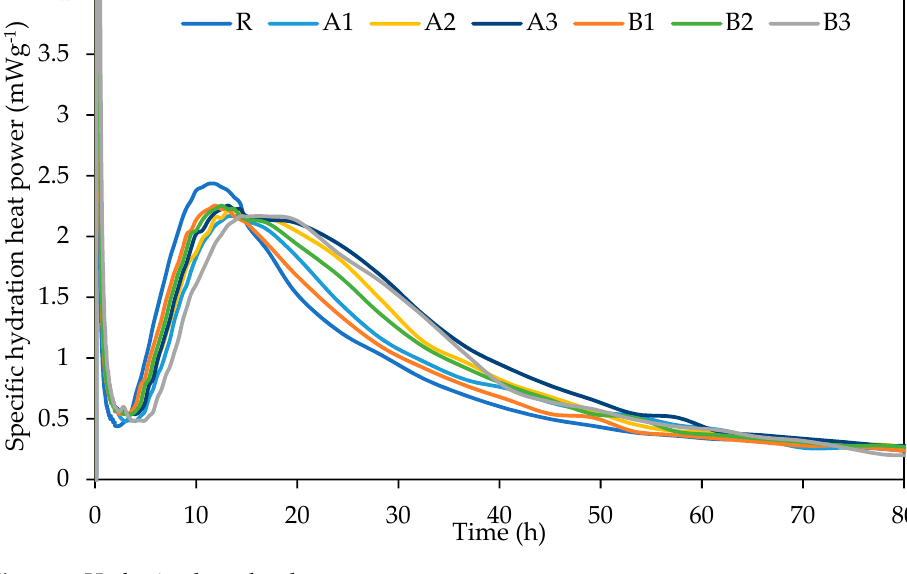
Figure 6. Hydration heat development.